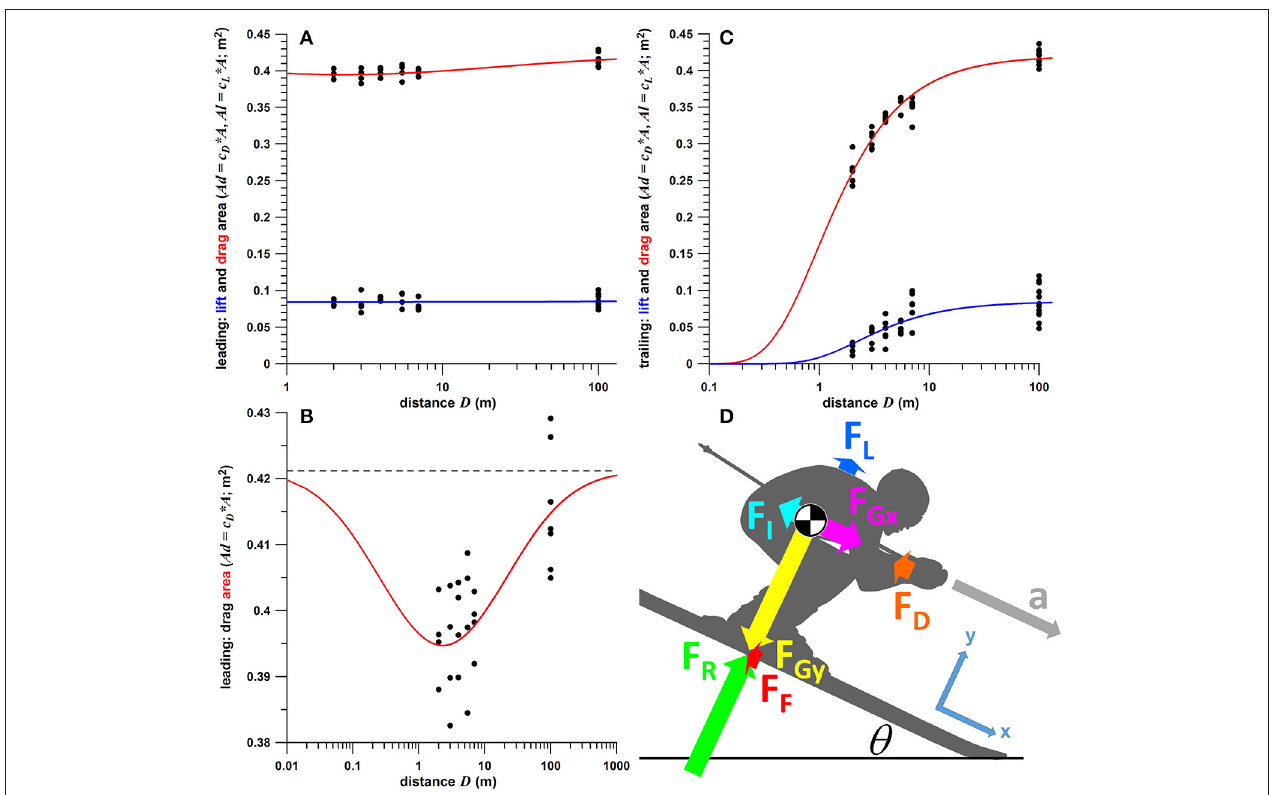
FIGURE 1 | (A–C) Drag and lift area, Ad and Al (coefficient of drag and lift times projected area) against distance between the two skiers (data from Fuss, 2011) including fit functions (red: drag area, blue: lift area); (A) leading skier; (B) enlarged graph of drag area of leading skier; (C) trailing skier; (D) free body diagram of a skier (the coordinate system of which is aligned to the slope), including vectors of acceleration ( a ) and forces ( F D and F L are drag and lift forces; F Gx and F Gy are the x - and y -components of the gravitational force; F R is the ground reaction force acting on the skis; F F is the friction force acting on the skis; and F I is the inertial force); the relative size of the force vectors is true for a slope angle ( θ ) of 25 ◦ , a mass of 100kg (body plus gear), and a speed of 100 kph;